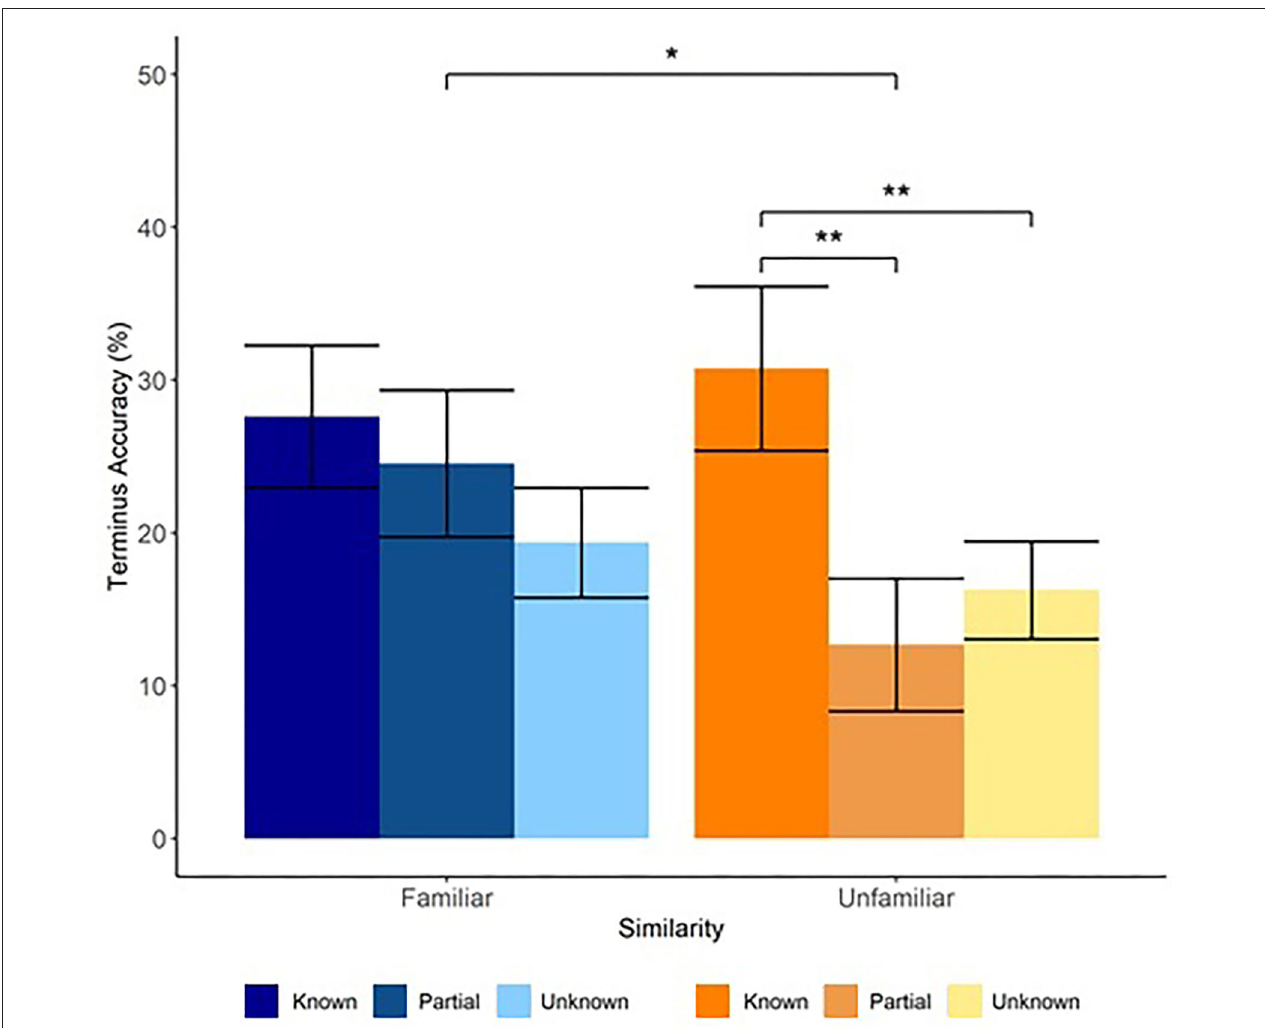
FIGURE 2 | Similarity to previously-learned novel words influences later acquisition. Word learning in the Bridge session affected the likelihood of learning its orthographic neighbor in the Terminus session. The effect of prior novel word learning was moderated by similarity to the native language. Accuracy in the Unfamiliar condition was higher for Known Neighbor words (dark orange) than for Partly-Known Neighbor words (orange) and Unknown Neighbor words (light orange); accuracy for Partly-Known and Unknown Neighbor words did not differ from each other. Accuracy in the Familiar condition did not differ between Known Neighbor words (dark blue), Partly-Known Neighbor words (blue), and Unknown Neighbor words (light blue). Error bars represent standard error (by participants). * p < 0.05; ** p <